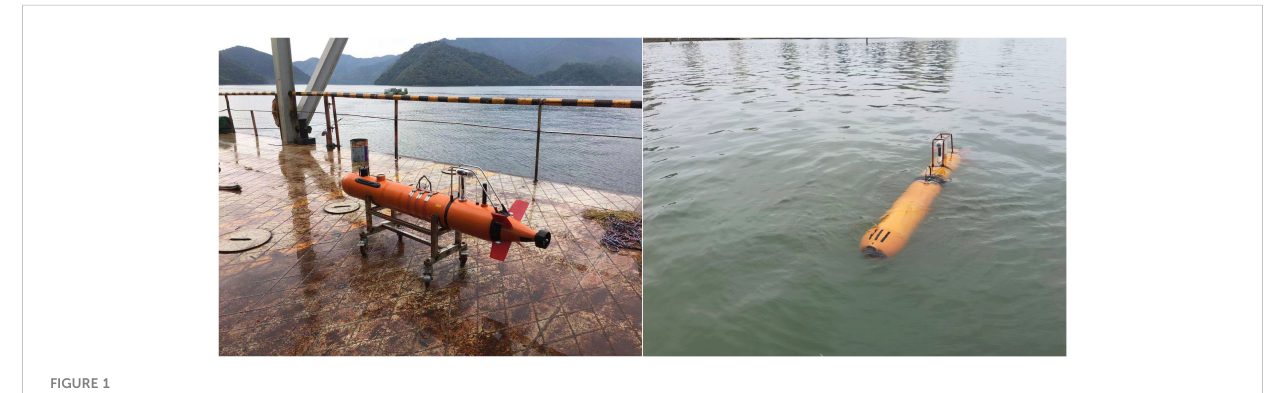
FIGURE 1 AUV for underwater ice